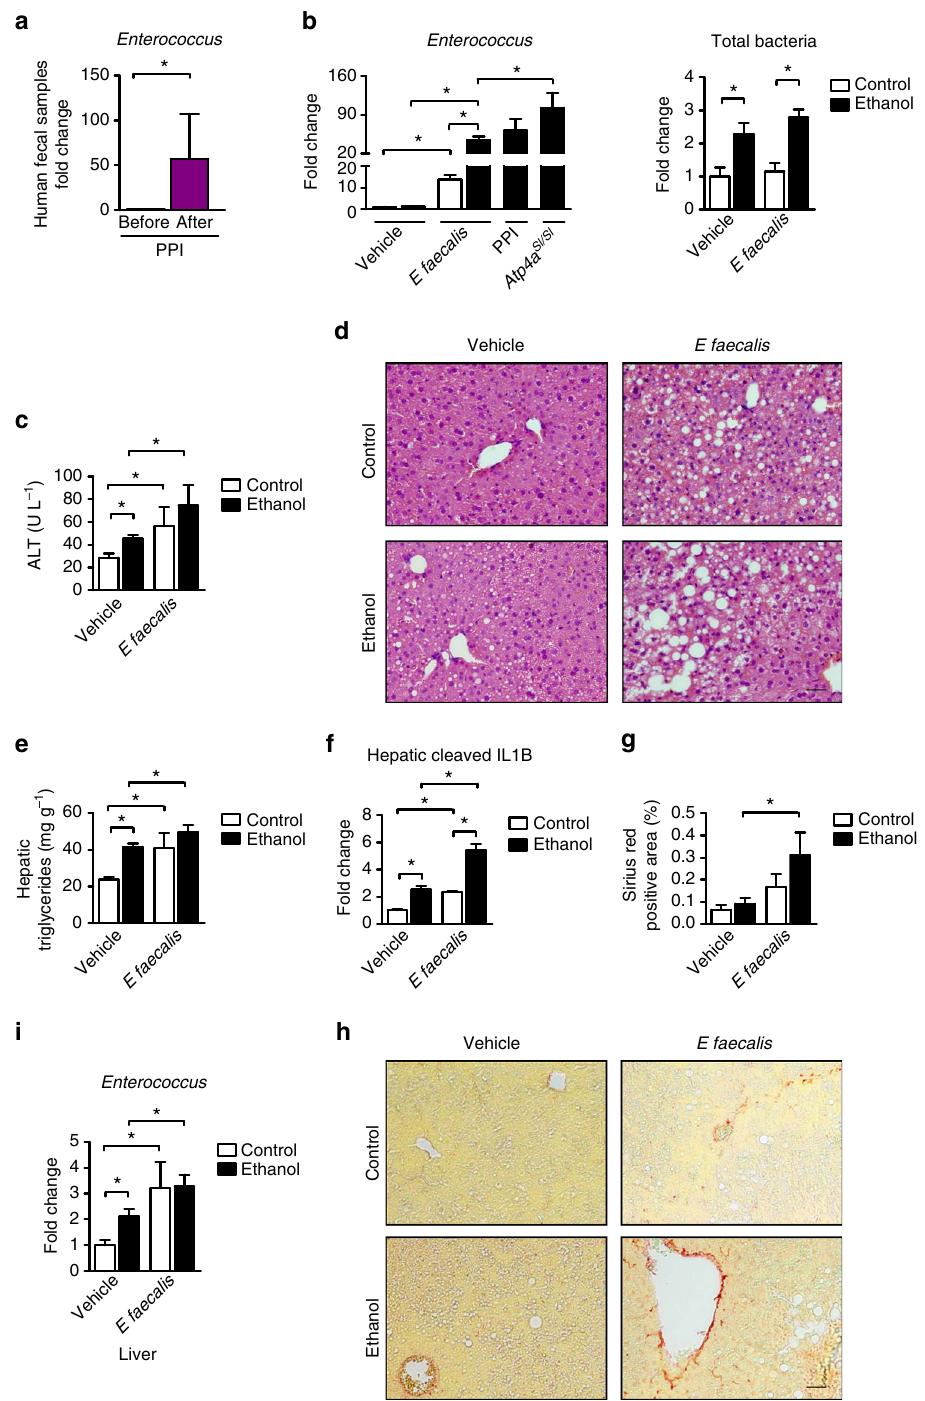
Fig. 6 Numbers of Enterococcus in human fecal samples and effects of E. faecalis on progression of alcohol-induced liver disease in mice. a Fecal amounts of Enterococcus in healthy individuals before ( n = 13) and after taking a PPI (omeprazole, 40 mg) daily for 14 days ( n = 12). b – i C57BL/6 mice were gavaged with polymyxin B 150 mg kg − 1 and neomycin 200 mg kg − 1 body weight once daily for 1 week to facilitate colonization of E. faecalis . Mice were then fed an oral control diet ( n = 3 – 9; 1 – 2 replicates) or ethanol diet ( n = 13 – 25; 1 – 2 replicates) for 9 weeks and gavaged with E. faecalis (5 × 10 9 CFUs) or vehicle (water) every third day. b Enterococci ( left panel ) and total amount of bacteria ( right panel ) in feces. Samples used to measure enterococci in ethanol-fed Atp4a Sl/Sl mice and in C57BL/6 mice fed ethanol or given PPIs are the same as in Figs. 1g and 2g, respectively. c Plasma levels of ALT. d Representative liver sections after hematoxylin and eosin staining. e Hepatic triglyceride content. f Hepatic expression of cleaved IL1B protein ( n = 2 – 5). g Hepatic areas of fi brosis were identi fi ed by staining with Sirius red ( n = 3 – 10); area was quantitated by image analysis software. h Representative Sirius red-stained liver sections. i Enterococcus in liver, assessed by qPCR. Scale bars = 100 μ m. Results are expressed as mean ± s.e.m. For a – c , e – g , i signi fi cance was evaluated using the unpaired Student t -test or Mann – Whitney U -statistic test. * P <